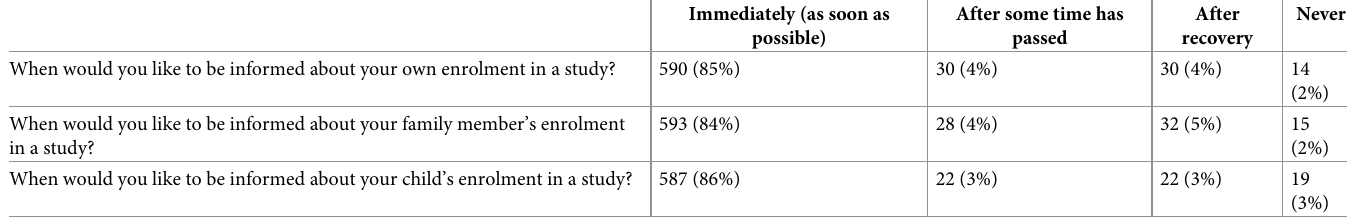
Table 4. Timing of seeking delayed consent.